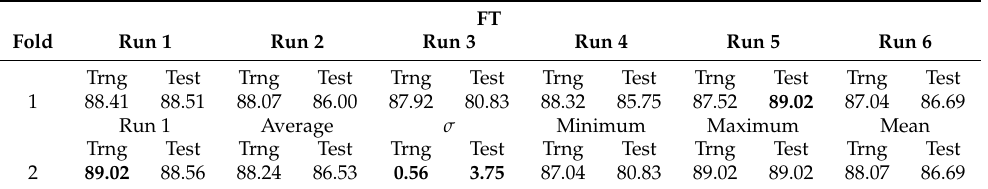
Table 17. Performance of the best individuals of the GBVSBP + MCG model for all FT database runs. Each pair of training and testing corresponds to one of seven experiments. Then, we report the average, standard deviation, minimum, maximum, and mean for the seven